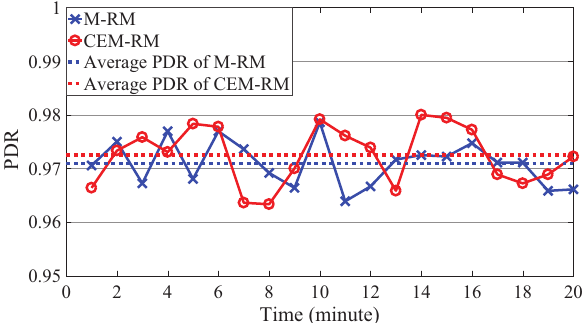
Figure 12. The packet delivery ratios of CEM-RM and